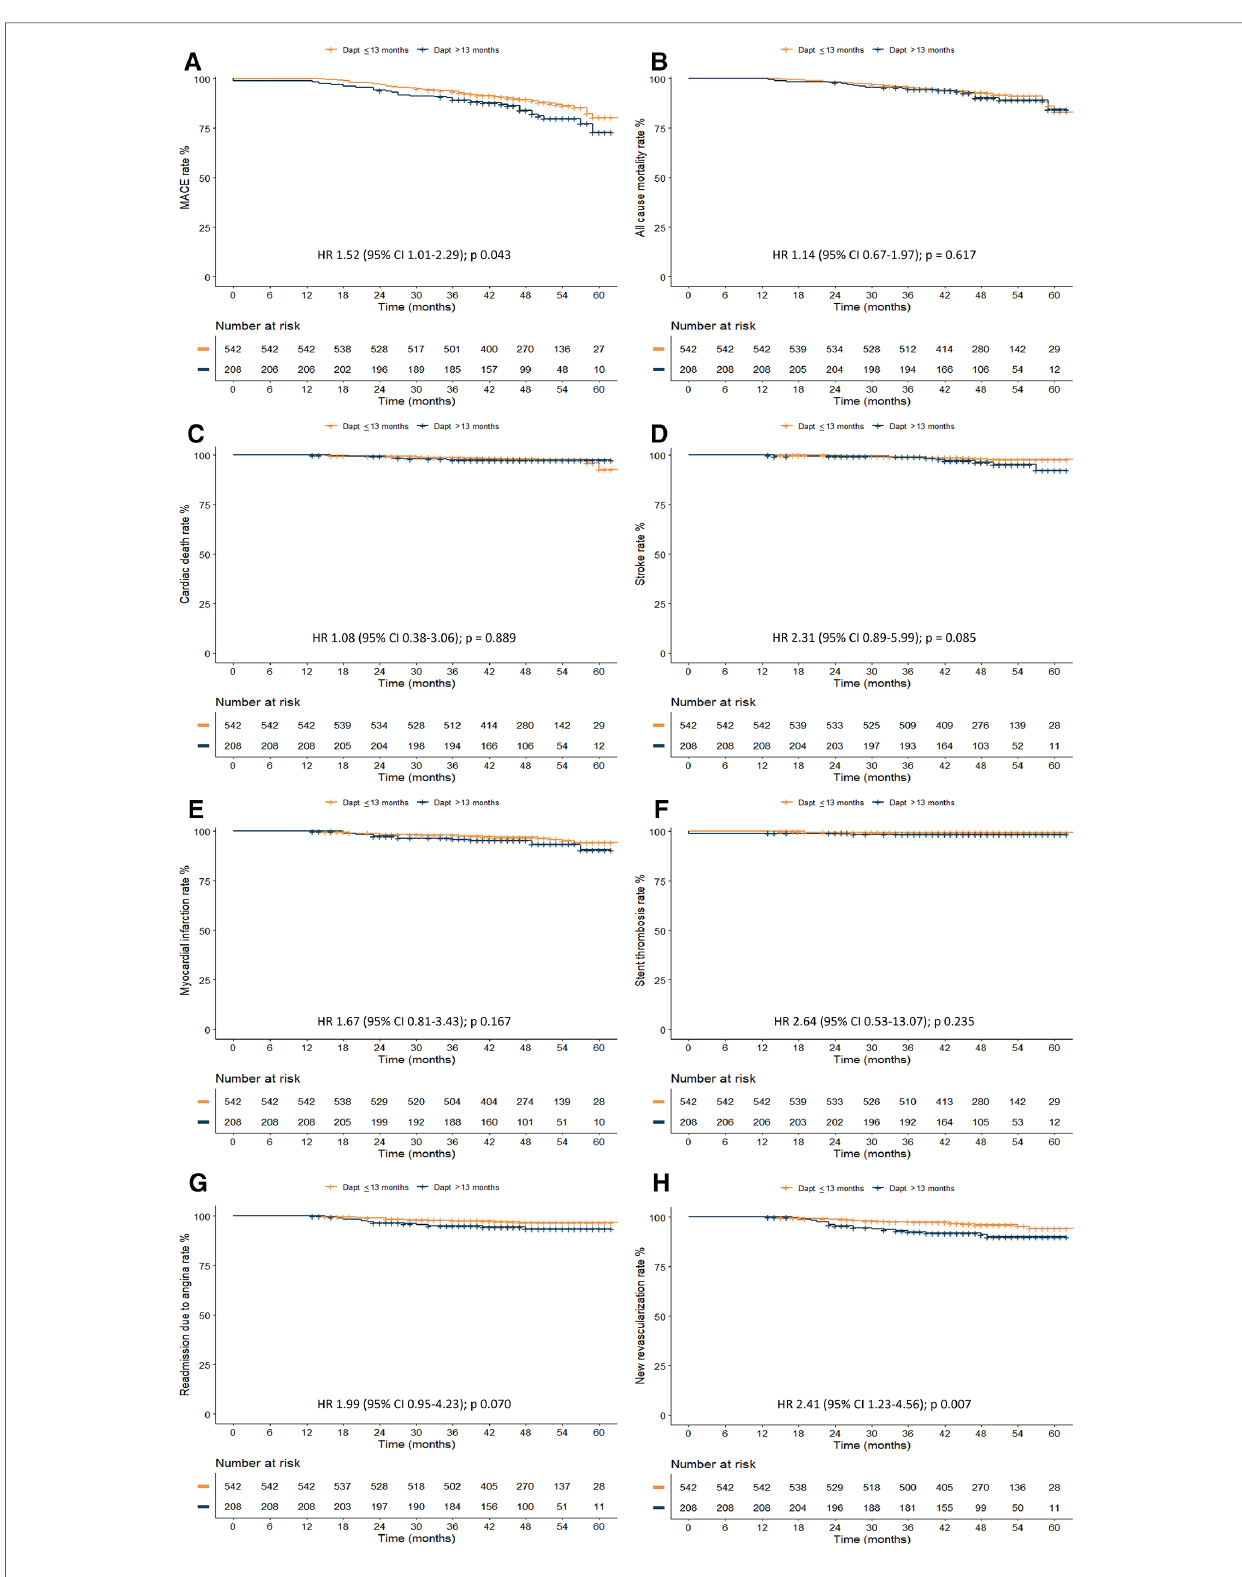
FIGURE 2 Kaplan – Meier curves for clinical outcomes according to DAPT duration. ( A ) MACE, ( B ) All cause mortality, ( C ) Cardiac death, ( D ) Stroke, ( E ) Myocardial infarction, ( F ) Stent thrombosis, ( G ) Readmission due to angina, ( H ) New revascularization.